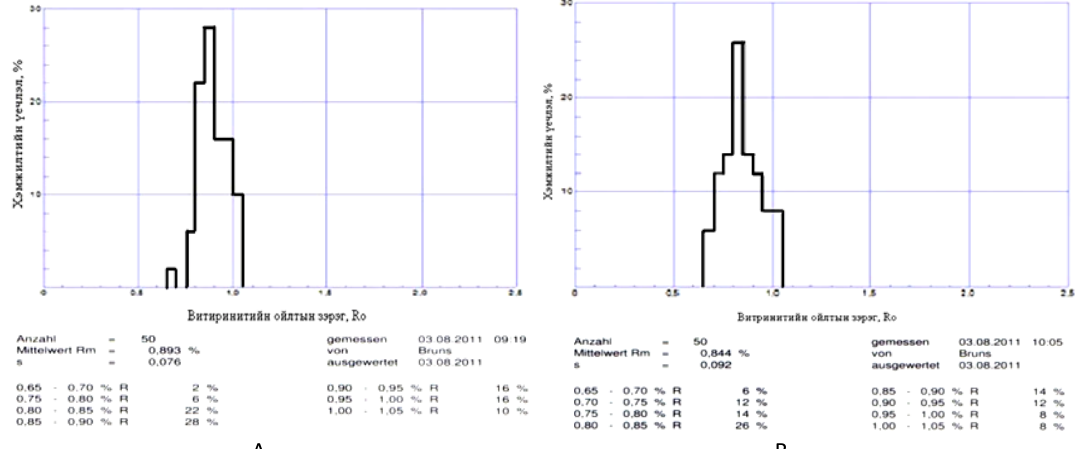
Fig. 2. The diagrams for determination of averaged value of %R